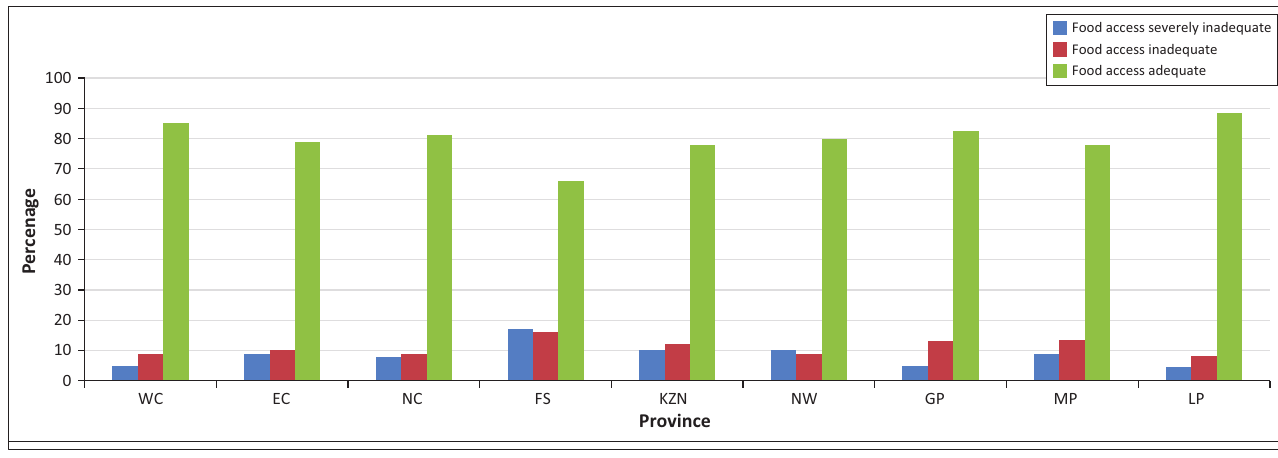
FIGURE 3: Household food adequacy by province over the period